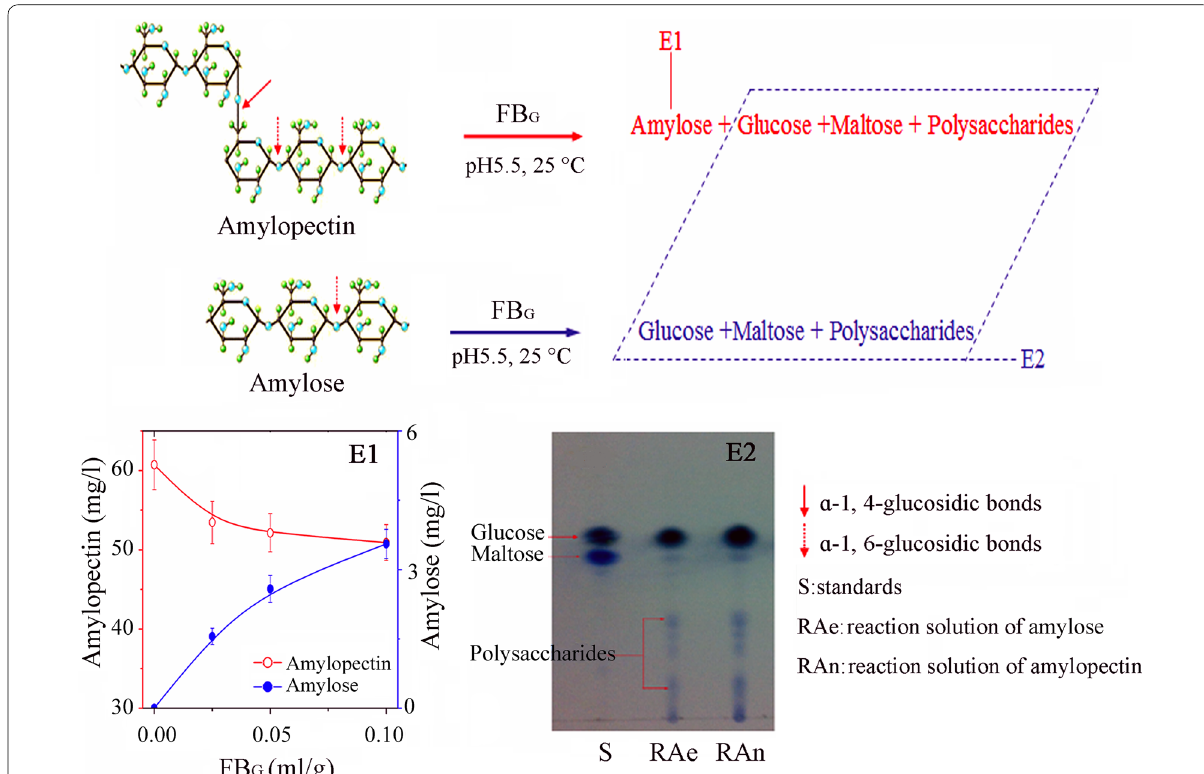
Fig. 7 Reactions and evidences of starch degradation catalyzed by FB G . E1, The concentrations of amylopectin and amylose after 3 h reaction; E2, TLC analysis of the products of amylopectin and amylose treated by FB G